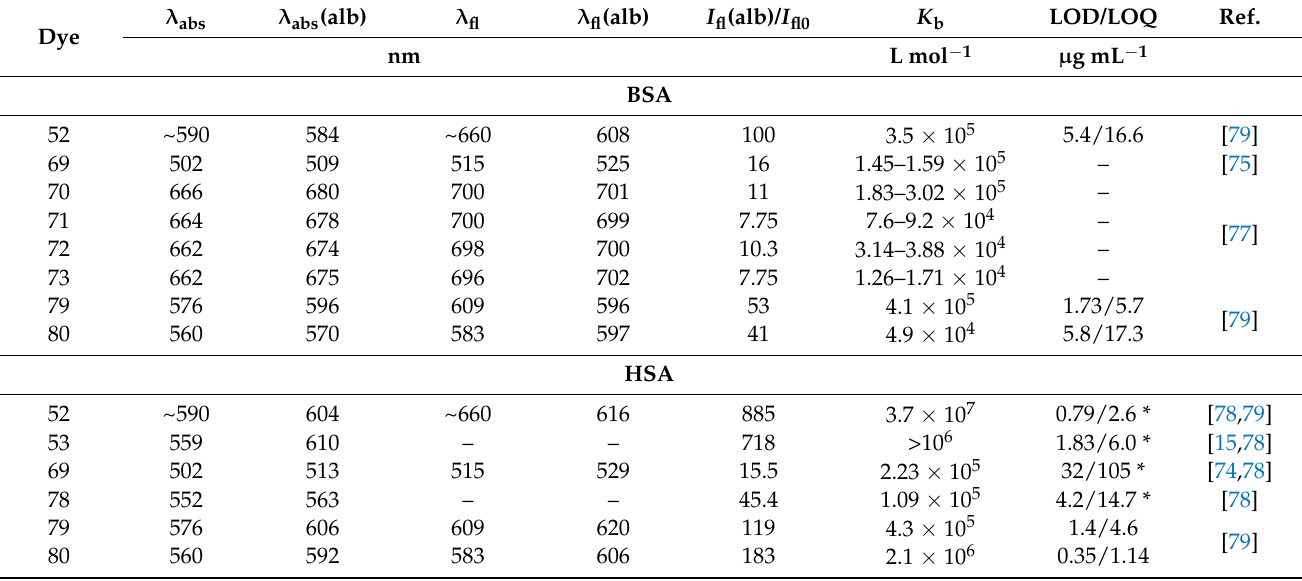
Table 4. Spectral-fluorescent properties of trimethine cyanine dyes in complexes with BSA and HSA (in the presence of high concentrations of albumins): maxima of the absorption and fluorescence spectra λ abs , λ fl , λ abs (alb), and λ fl (alb), respectively, ratios of fluorescence intensities in the presence and in the absence of albumin I fl (alb)/ I fl , and dye–albumin binding constants K b and limits of detection/quantification of albumin LOD/LOQ using the dyes as probes.